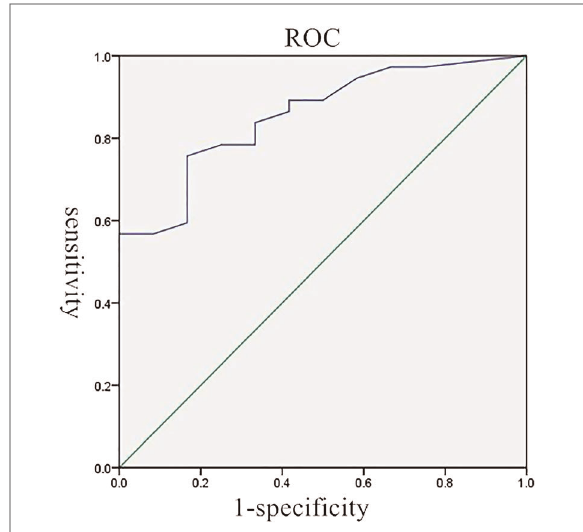
FIGURE 1 The ROC for pleural thickness in predicting the diagnostic value of US-PPNB in terms of MPM. ROC, receiver operator curve; US- PPNB, ultrasound-guided percutaneous pleural needle biopsy; MPM, malignant pleural